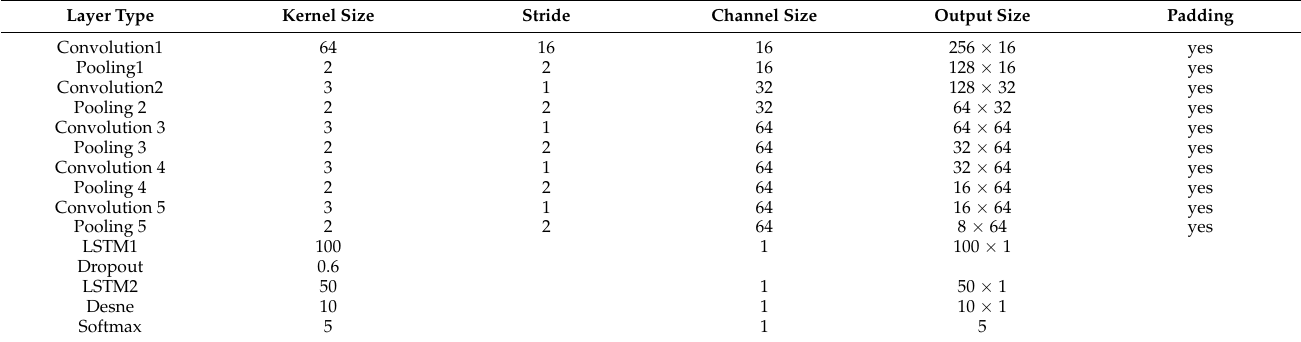
Table 2. Structure parameters of model network.